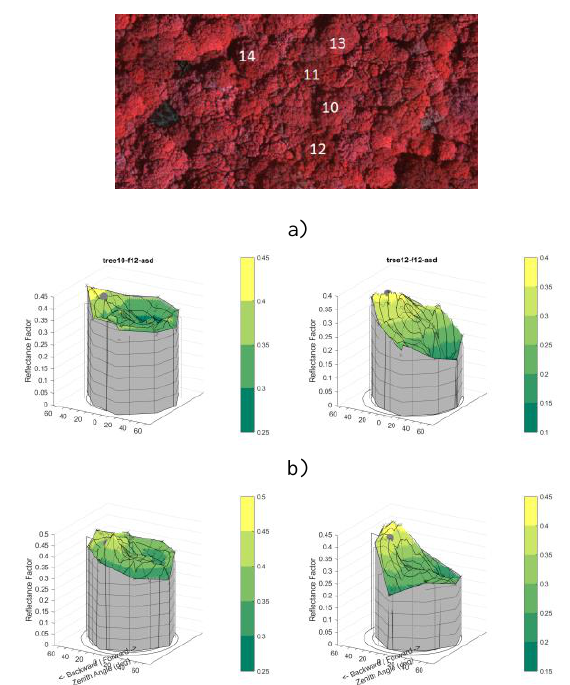
Figure 14. Preliminary HRDFs of trees 10 (left) and 12 (right) sampled from a) morning and b) afternoon